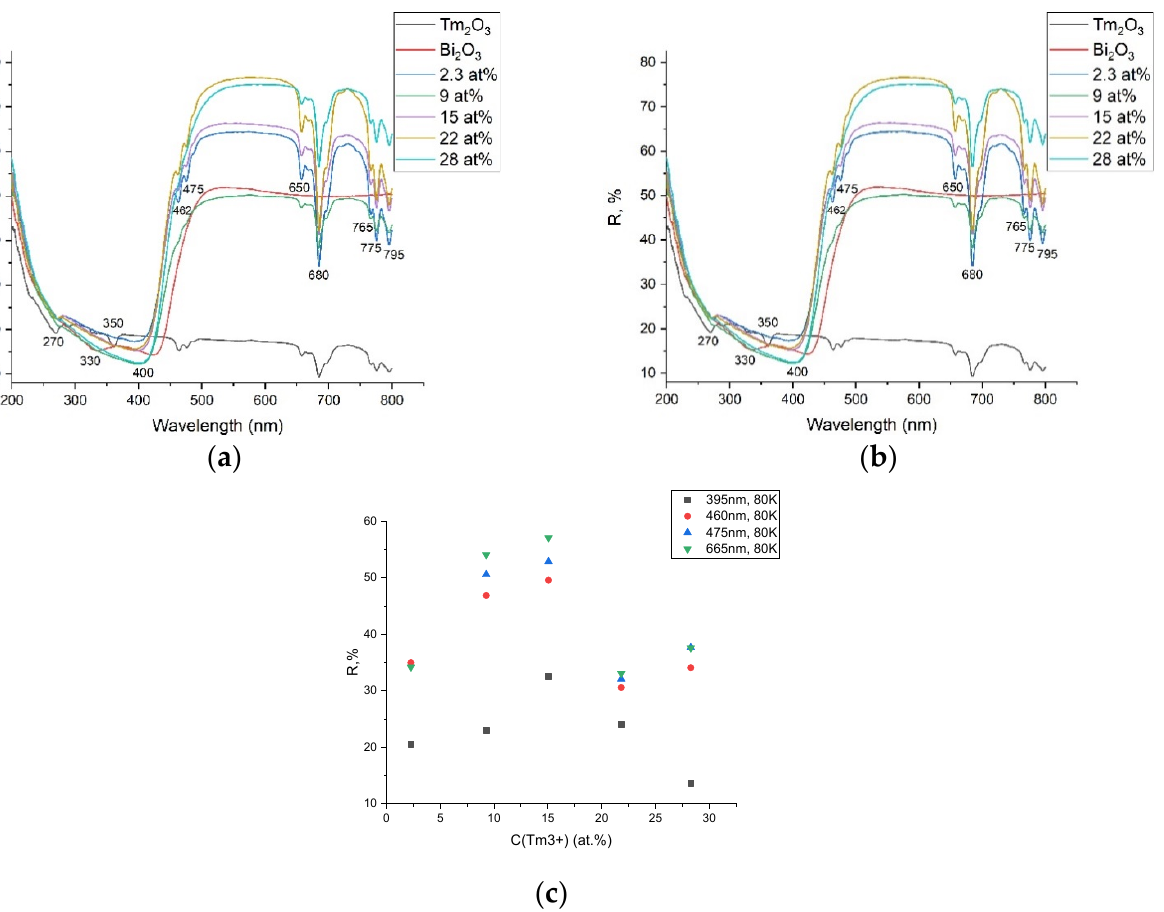
Figure 6. Reflection spectra of Bi 2 O 3 /Tm 2 O 3 oxides with different atomic concentrations of Tm 3+ in the mixture (2.3–28 at.%) at T = 80 K ( a ), at T = 293 K ( b ) and dynamic of R(%) depending on the Tm 3+ concentration at T = 80 K ( c ).